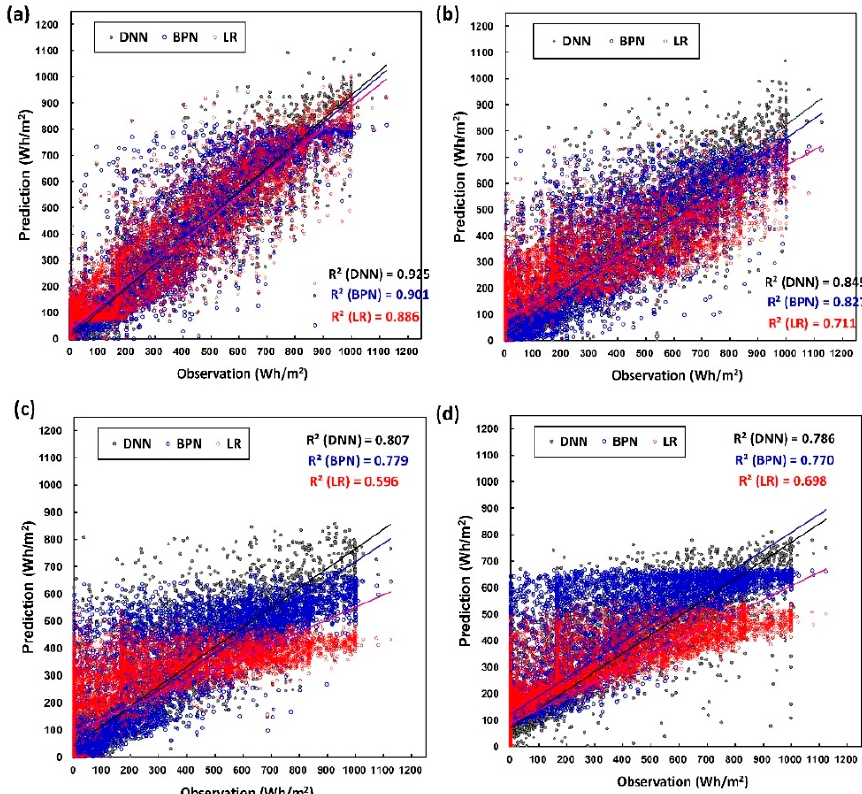
Figure 7. Scatter diagram of deep neural network (DNN), backpropagation neural network (BPN) and linear regression (LR) at the lead times of ( a ) 1; ( b ) 3; ( c ) 6 and ( d ) 12 h.